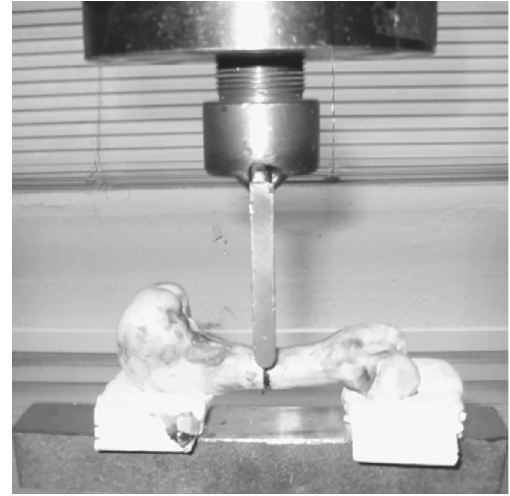
Fig. 1 Experimental setup showing three-point bending